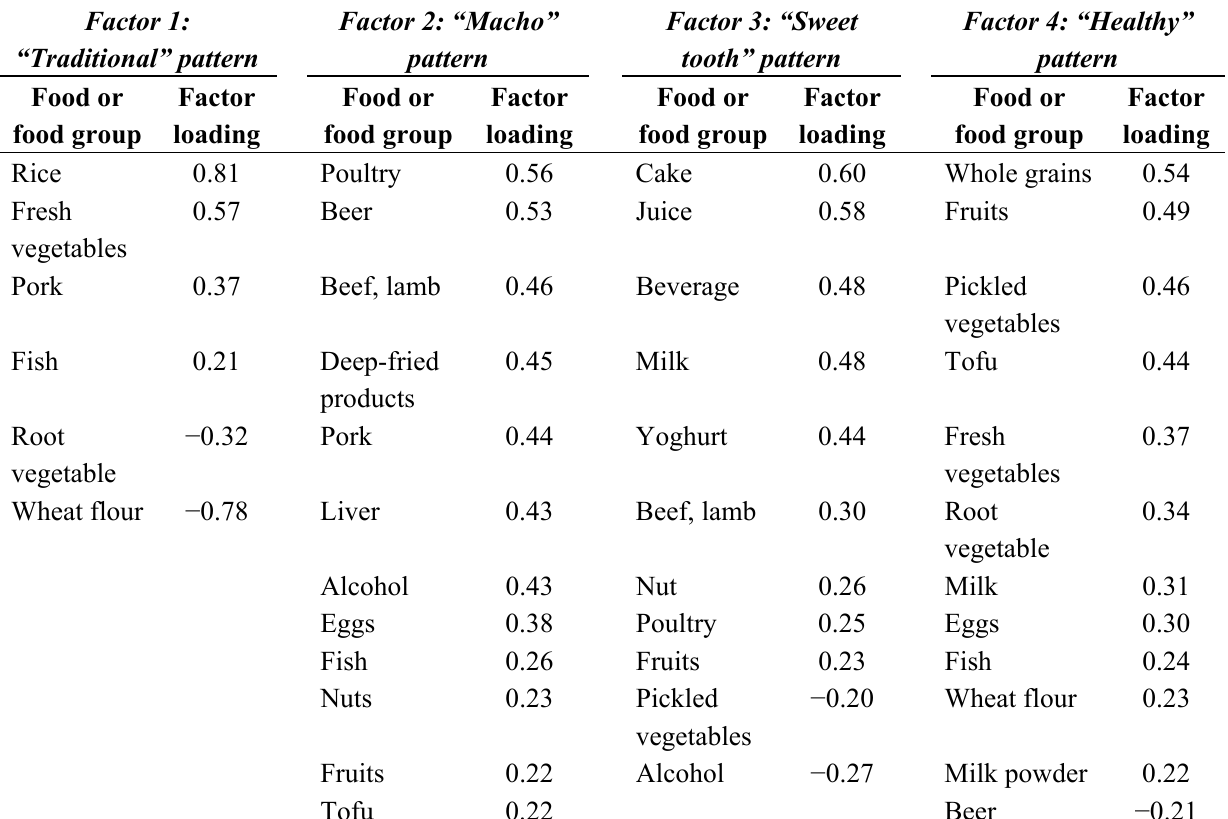
Table 1. Factor loading for four dietary patterns among